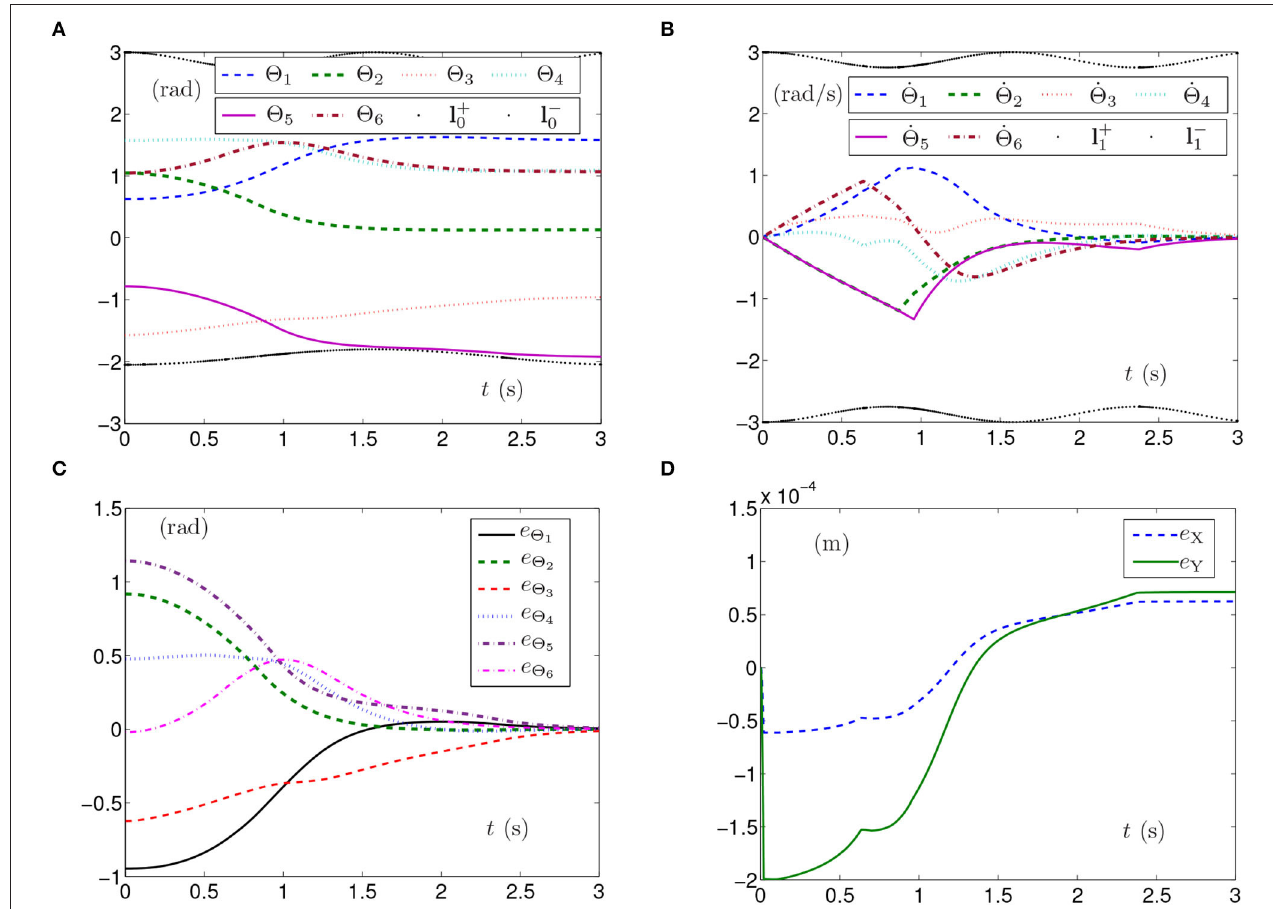
FIGURE 5 | Synthesized results of the planar manipulator using SMCS-2 with time-varying physical limits verged in case B. (A) Profiles of joint angles. (B) Profiles of joint-angle velocities. (C) Profiles of joint-angle errors. (D) Profiles of end-effector position errors.